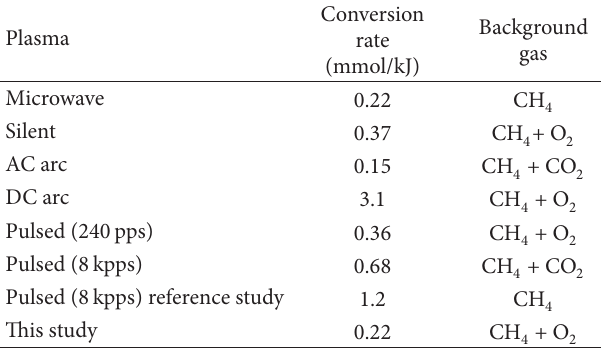
T 2: Energy efficiency in different plasma systems for conver- sion of